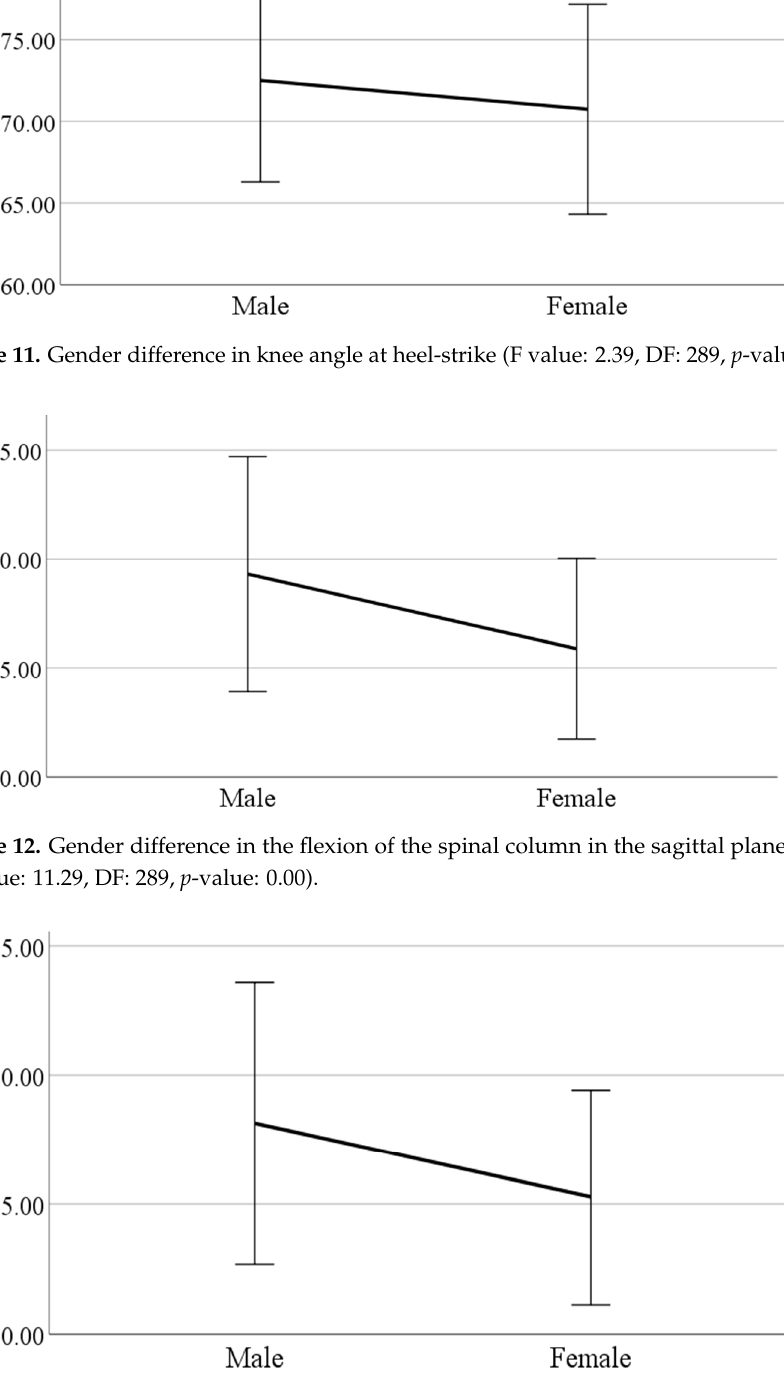
Figure 13. Gender difference in the flexion of the spinal column in the sagittal plane at toe-off (F